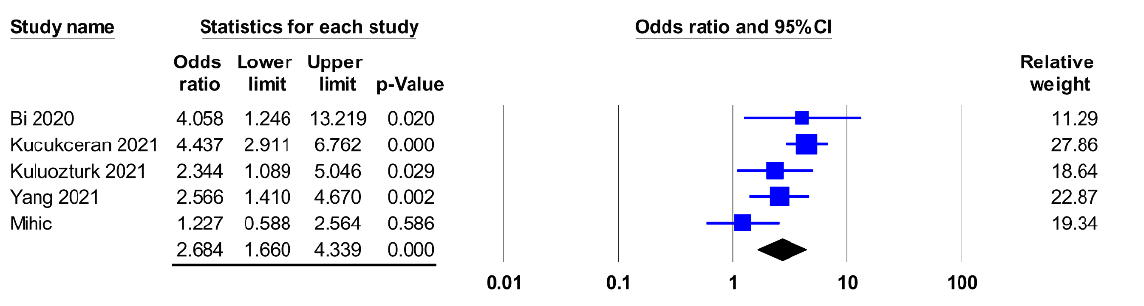
Figure 4. Forest plot demonstrating a positive correlation between risk of poor prognosis and fibrinogen-to-albumin ratio as a binary parameter (odds ratio: 2.684, 95% CI: 1.66 to 4.339, p < 0.001, I 2 = 59.5%) [12,34–36,38]. CI, confidence interval.